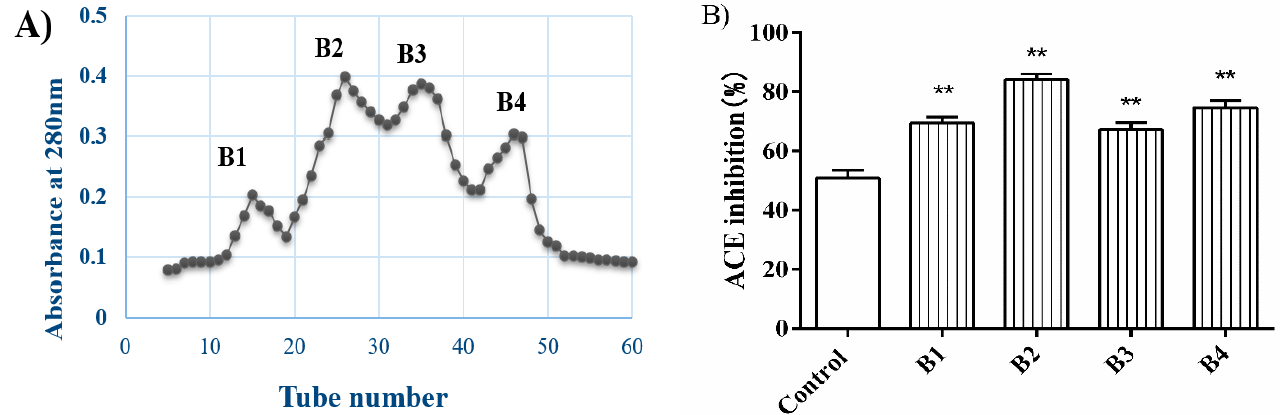
Figure 2. Sephadex G-15 gel chromatography separation of A3 ( A ) and ACE inhibitory rates of subfractions from A3 at the concentration of 1.0 mg/mL ( B ). Control: Glutelin-1 hydrolysate before separation and purification. All data are presented as the mean ± SD of triplicate results. ** p < 0.01, vs. the control, B1–B4 represent the four fractions separated by Sephadex G-15 gel chromatography.